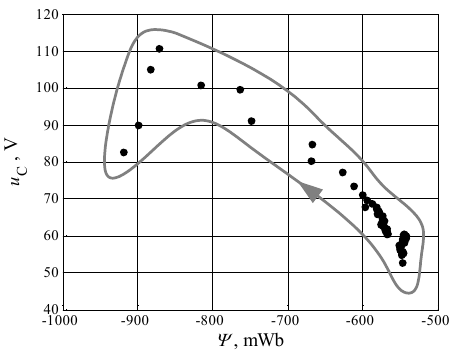
Fig. 4. Poincare map for the studied